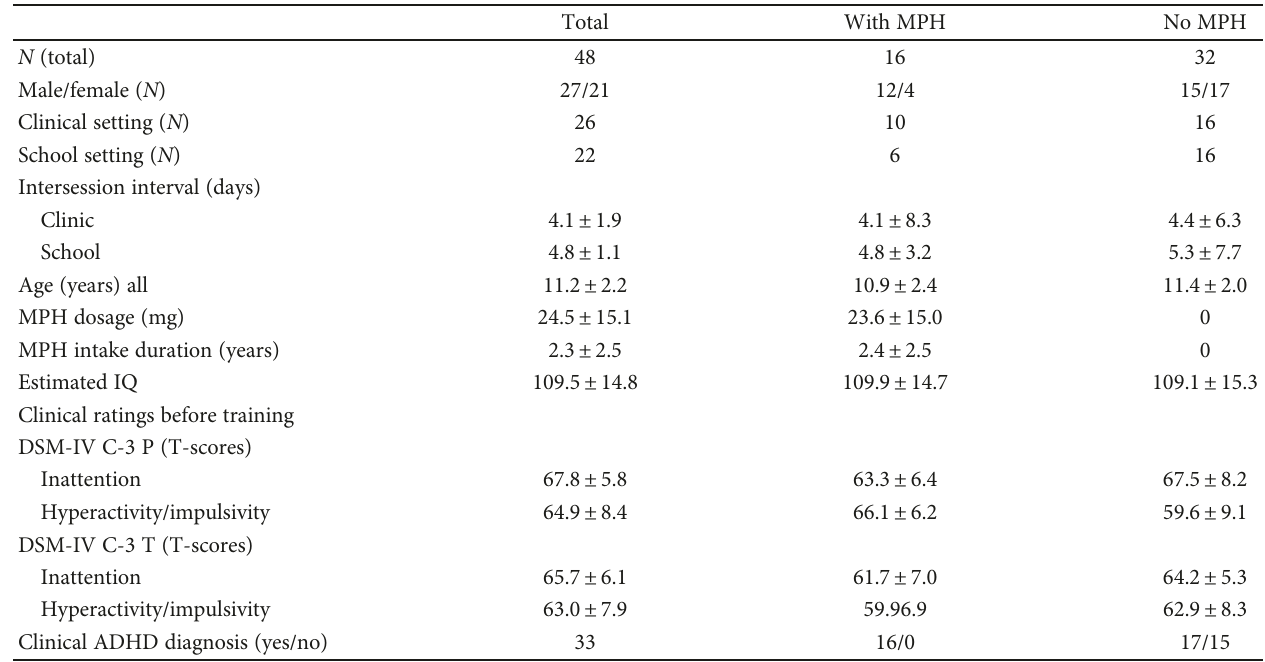
Table 1: Description of